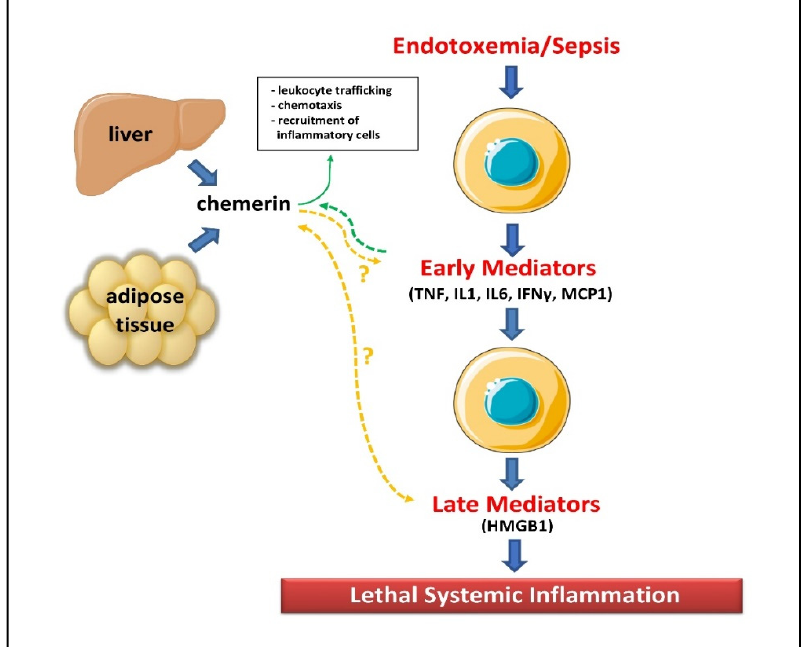
Figure 8. Actions of chemerin and cytokines that are secreted during sepsis. Abbreviations: HMGB1, high mobility group box 1; IFN, interferon; IL, interleukin; MCP1, monocyte chemoattractant protein-1; TNF, tumor necrosis factor. (Images of the liver and macrophages are originated from the free medical website http://smart.servier.com/ (Accessed on 14